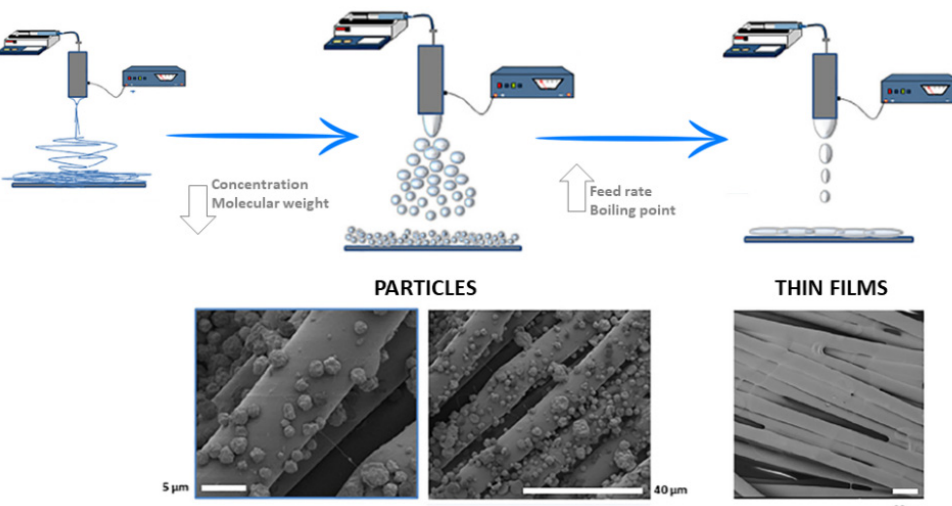
Figure 8. Scheme of experimental setup modifications of EFDTs for the fabrication of nanoparticles and thin films as sustainable coatings (images adapted from [128]). In comparison with the conven- tional setup used for the fabrication of electrospun fibers, the use of polymer solution with lower concentration/low molecular weight enables particles suitable for micro-nanostructured coatings. Likewise, a significant modification of fluid dynamic parameters (i.e., increase in flow rate) may also allow creation of a homogeneous and thin coating of porous substrates and textiles.